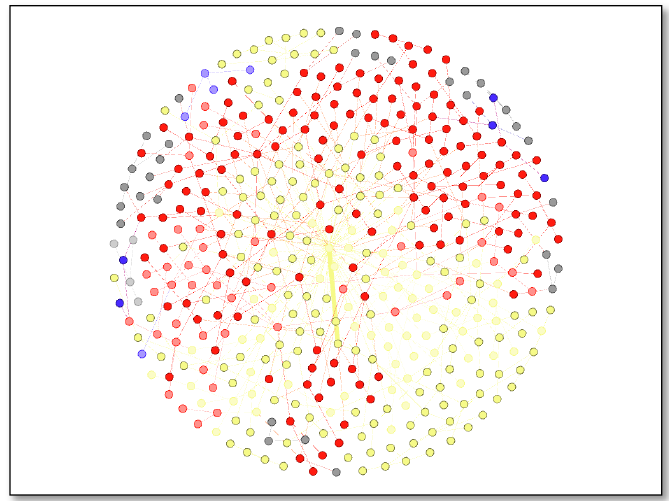
Figure 18. Publication Title and Citations-Network Visualization.